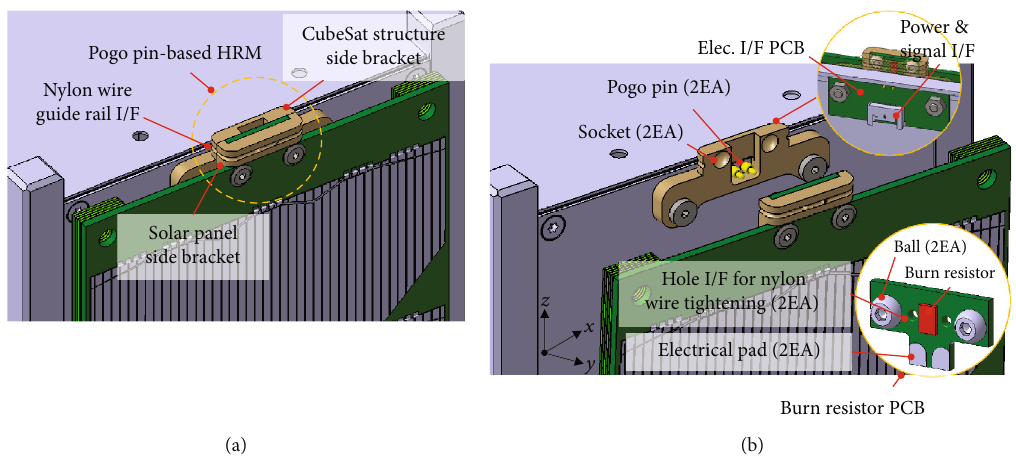
Figure 2: Close-up views of the pogo pin-based mechanism: (a) fully stowed and (b) partially stowed. Table 3: Basic speci fi cations of the hardware used in the